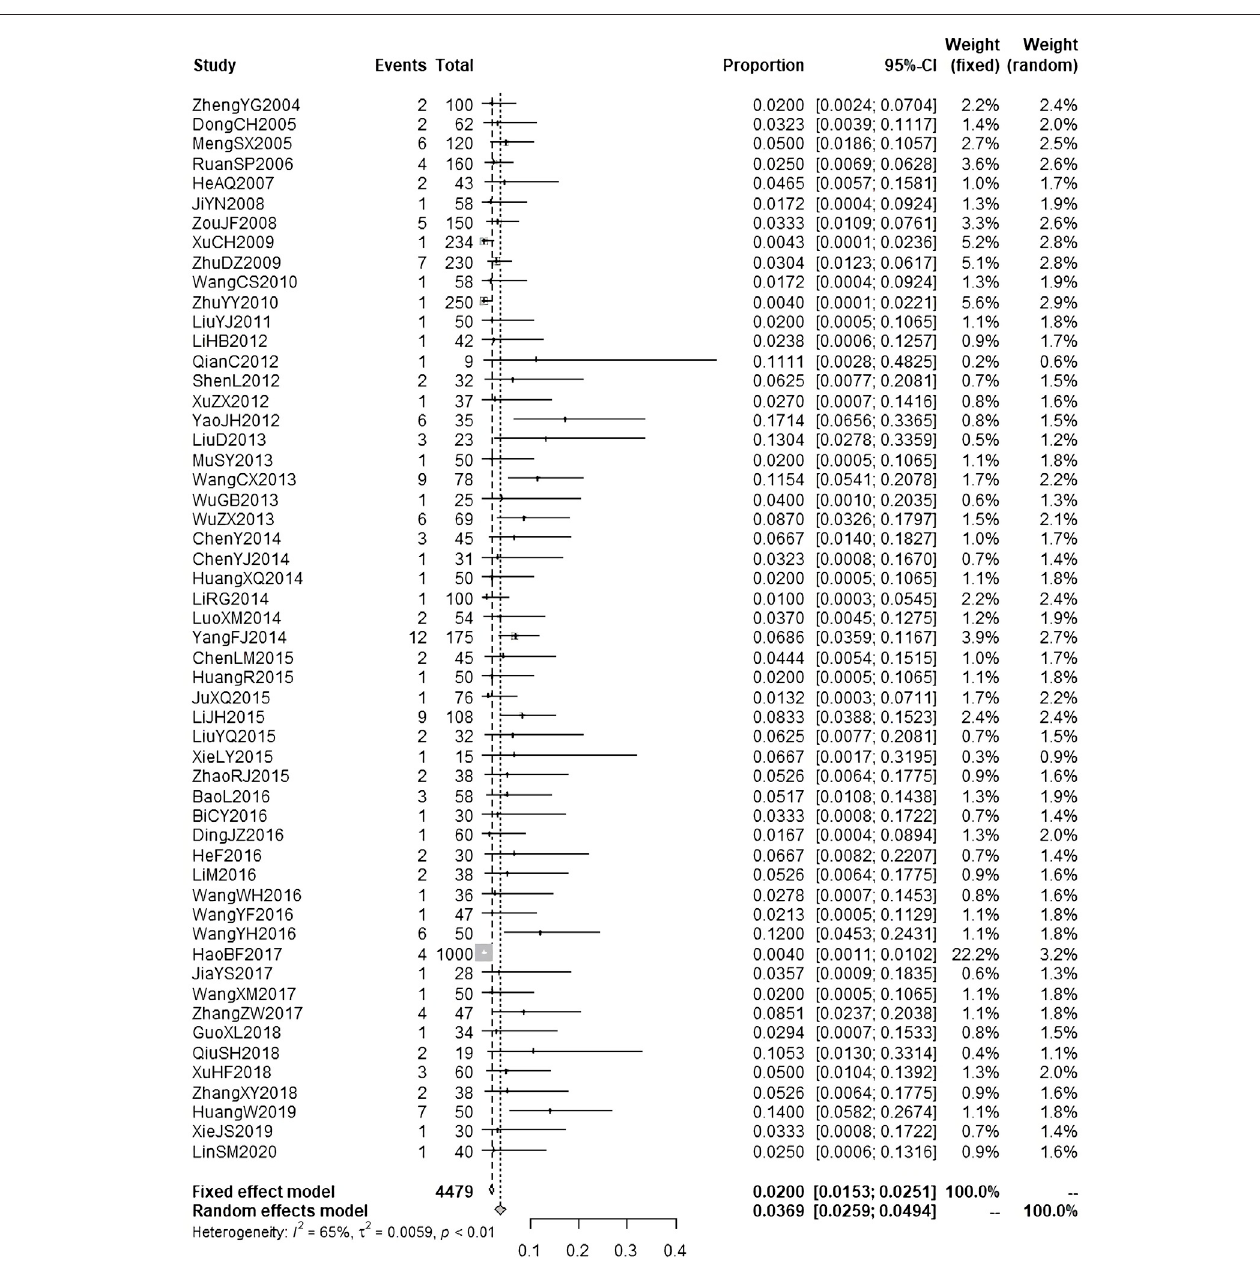
FIGURE 4 | Meta-analysis on ADR incidence of